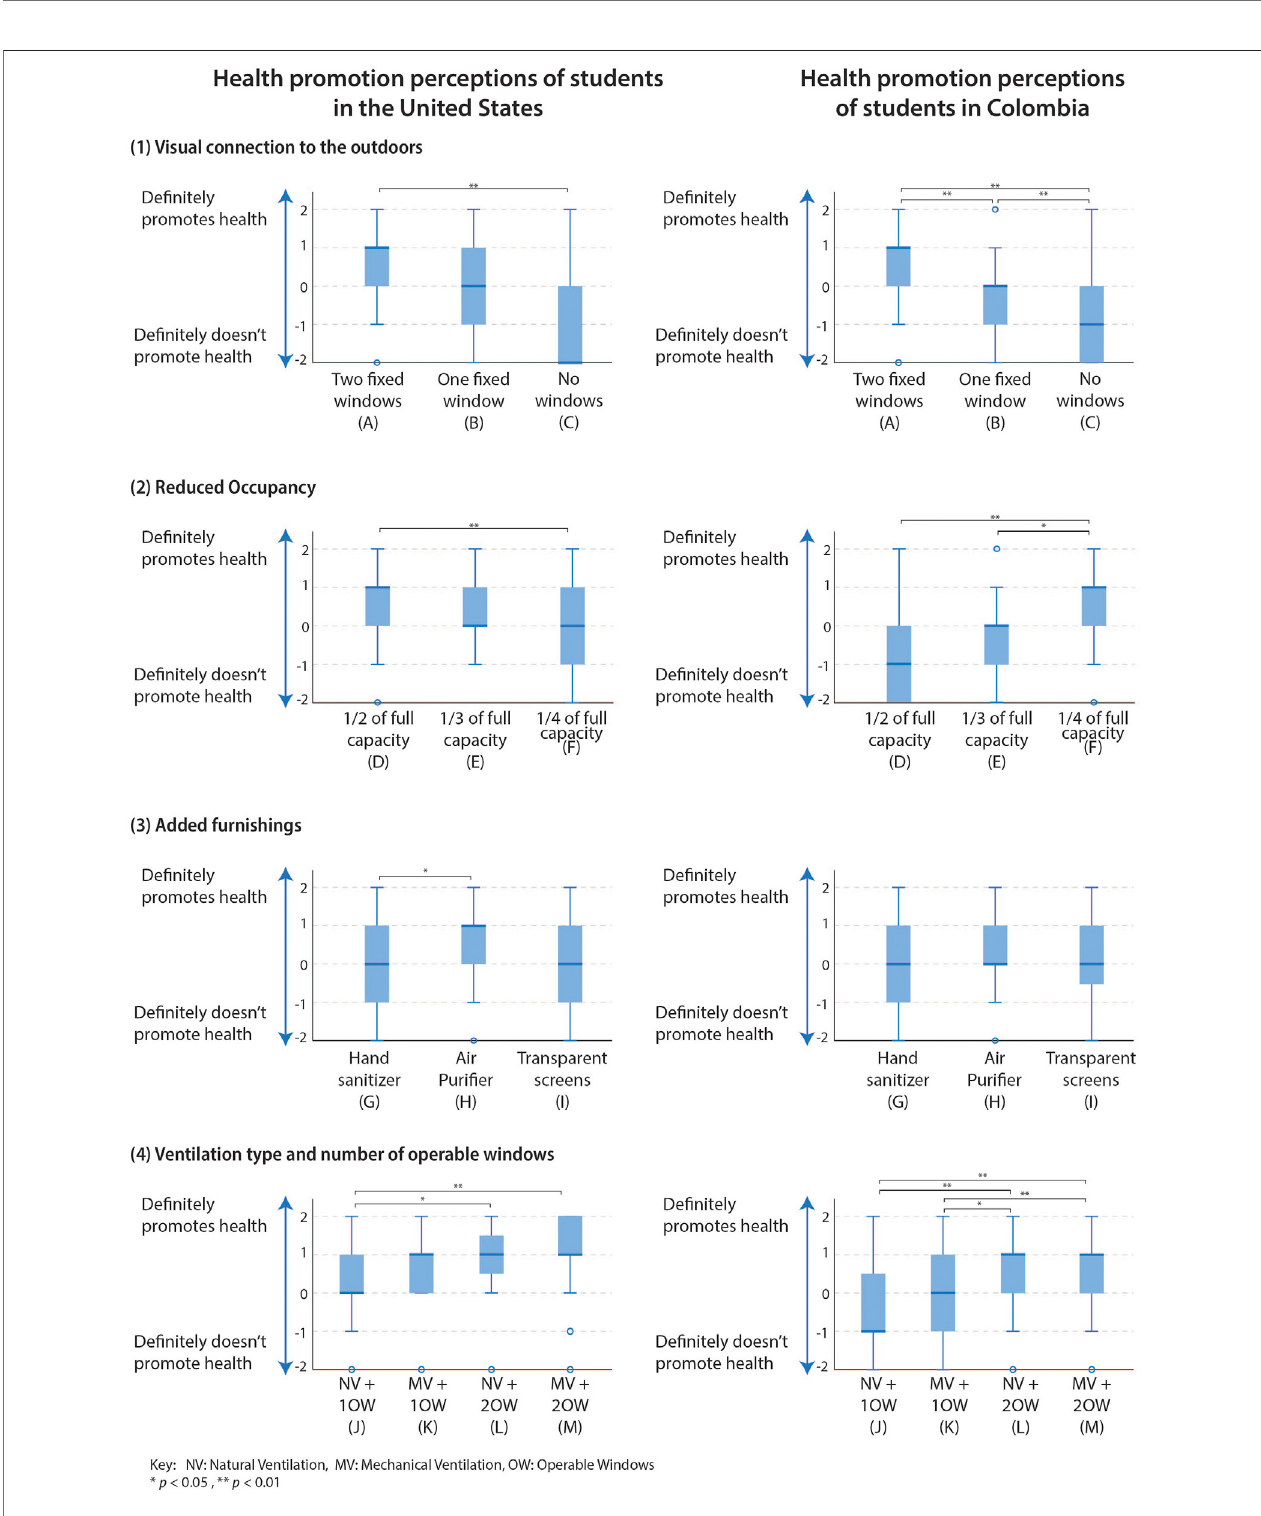
FIGURE 5 | Signi fi cant differences between scenarios in each category in Colombia. Signi fi cant differences noted with brackets within each graphic. ** represents p < 0.01, * represents p < 0.05. NV (cid:1) Natural Ventilation, MV (cid:1) Mechanical Ventilation, OW (cid:1) Operable windows.